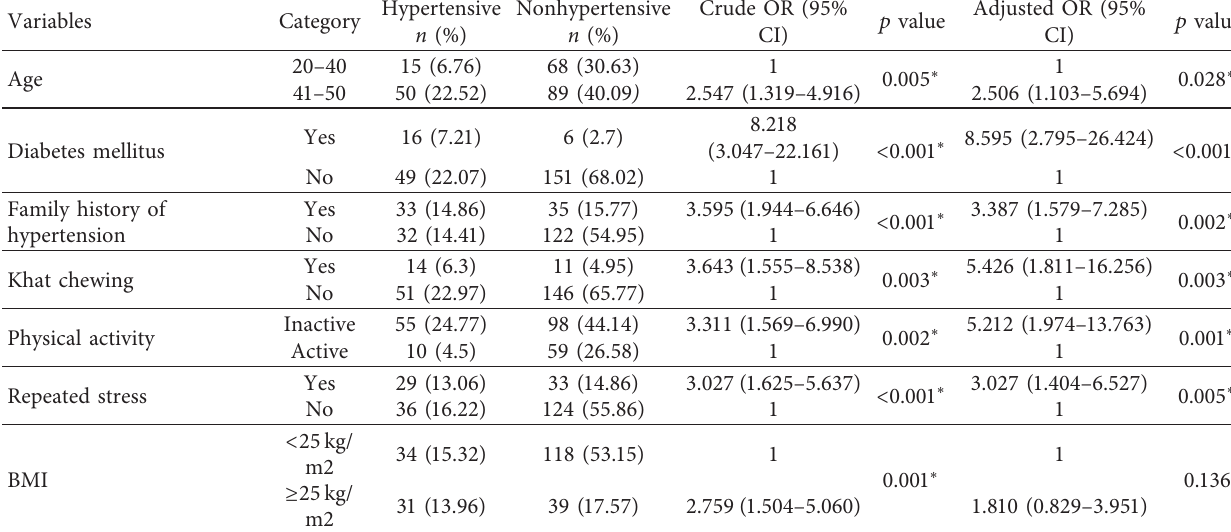
Table 4: Multivariate logistic regression analysis for the risk factors associated with hypertension, among Bahir Dar secondary school teachers, northwest Ethiopia, January 2020 ( n �